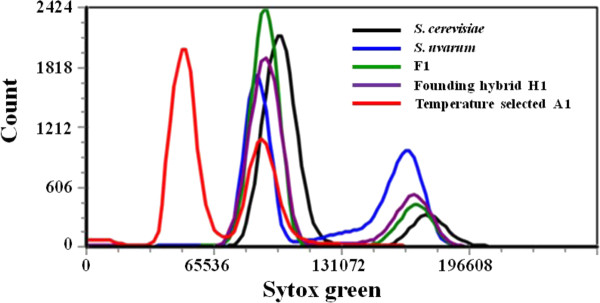
Ploidy of temperature-selected isolates differs from that of parental species, the F1 interspecific hybrid, and a founder hybrid. A representative isolate from Vessel A is presented. The transition from diploidy to haploidy in each temperature-selected population is presented in Figure S3. Cells were stained with SYTOX and sorted by flow cytometry.